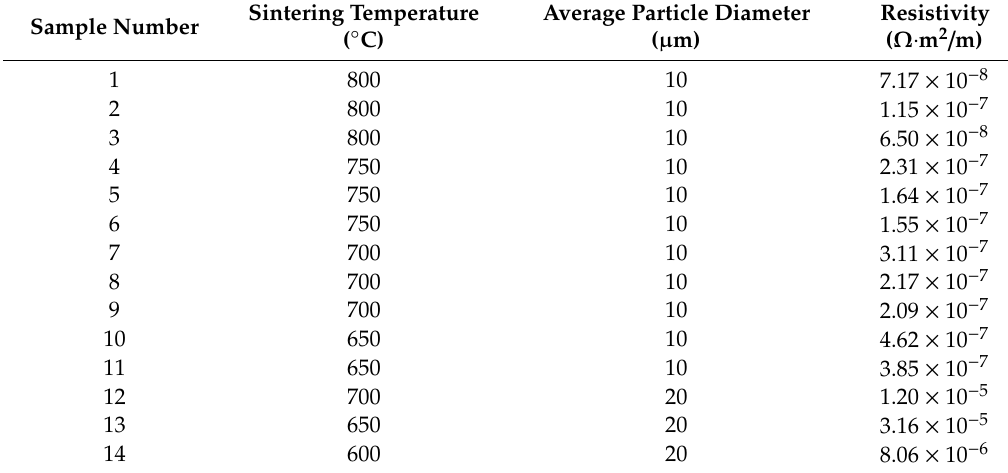
Table 2. Properties of di ff erent sintering temperatures and diameters of samples.